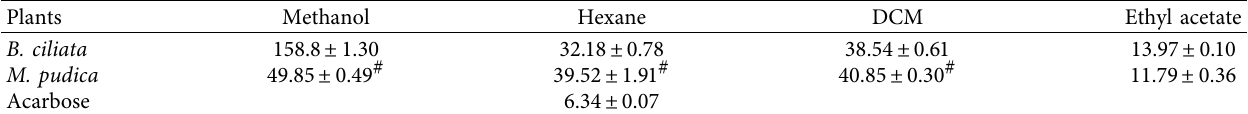
50 value (( μ g/mL) against α -amylase.